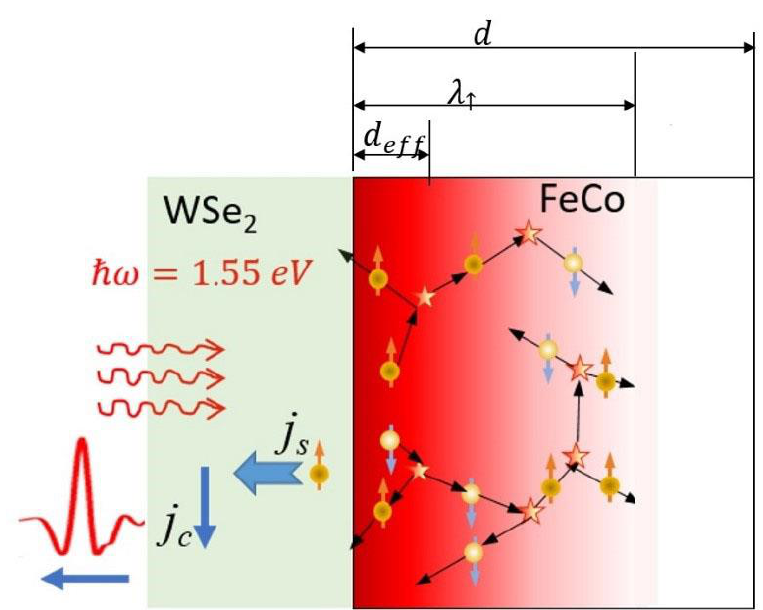
Figure 4. Schematic cross-section views of the structure WSe 2 /FeCo and representation of the backflow spin current arising in FM due to inelastic scattering. 𝑑— the FM layer thickness, λ ↑ — the majority electrons MFP, 𝑑 𝑒𝑓𝑓 — the maximal distance, which is necessary for scattered electrons to overcome and reach the WSe 2 /FeCo boundary in the ballistic or/and superdiffusion regime. Thus, we answer question (i): yes, the mechanism for THz radiation generation is the same in both transmission and reflection